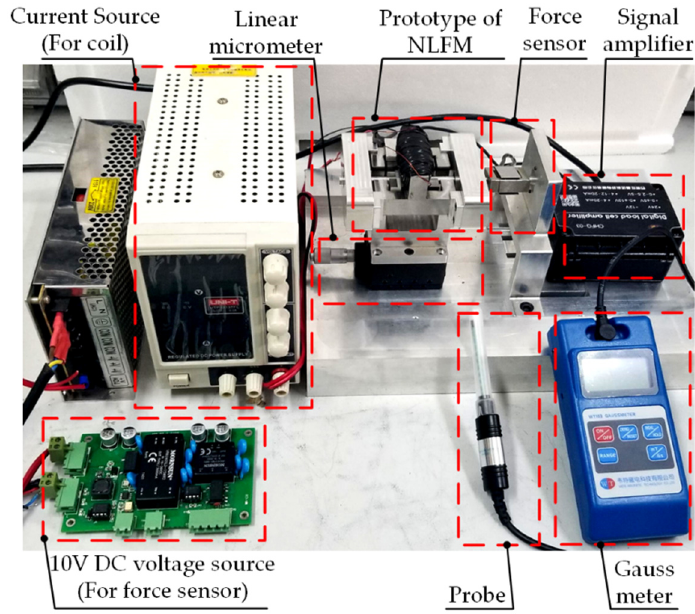
Actuators 2021 , 10 , 32 Figure 16. The experimental platform for the prototype of the NLFM. Figure 16. The experimental platform for the prototype of the NLFM.